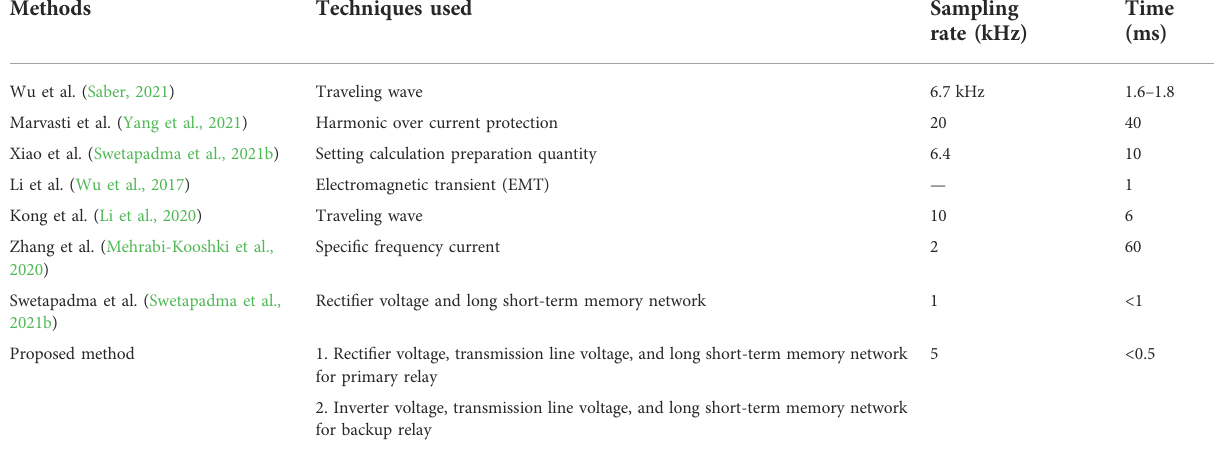
TABLE 10 Comparison with other methods.